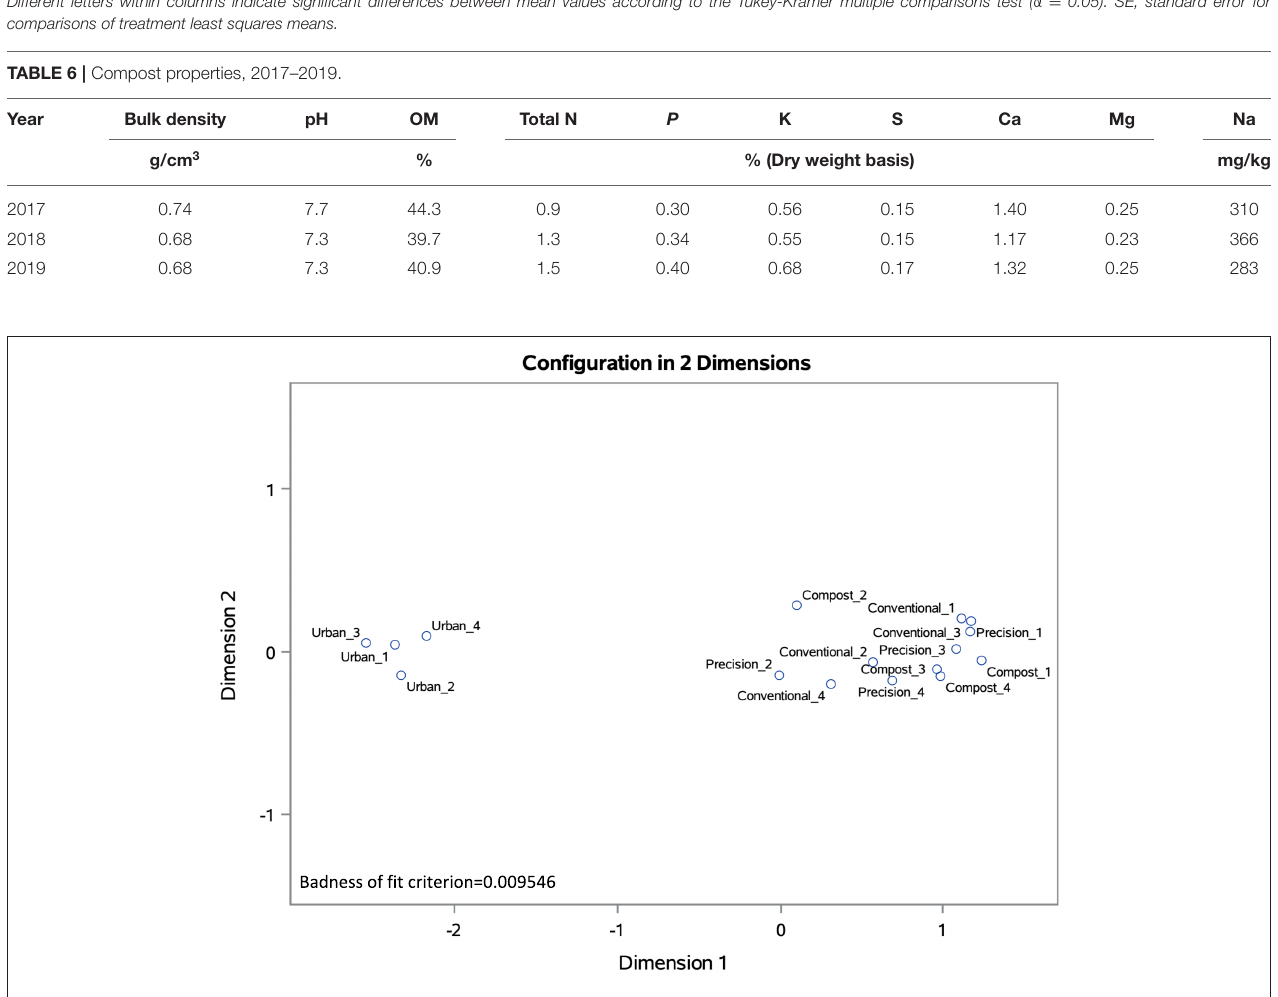
plots due to 3 years of annual application of compost to plot beds ( Figure 4